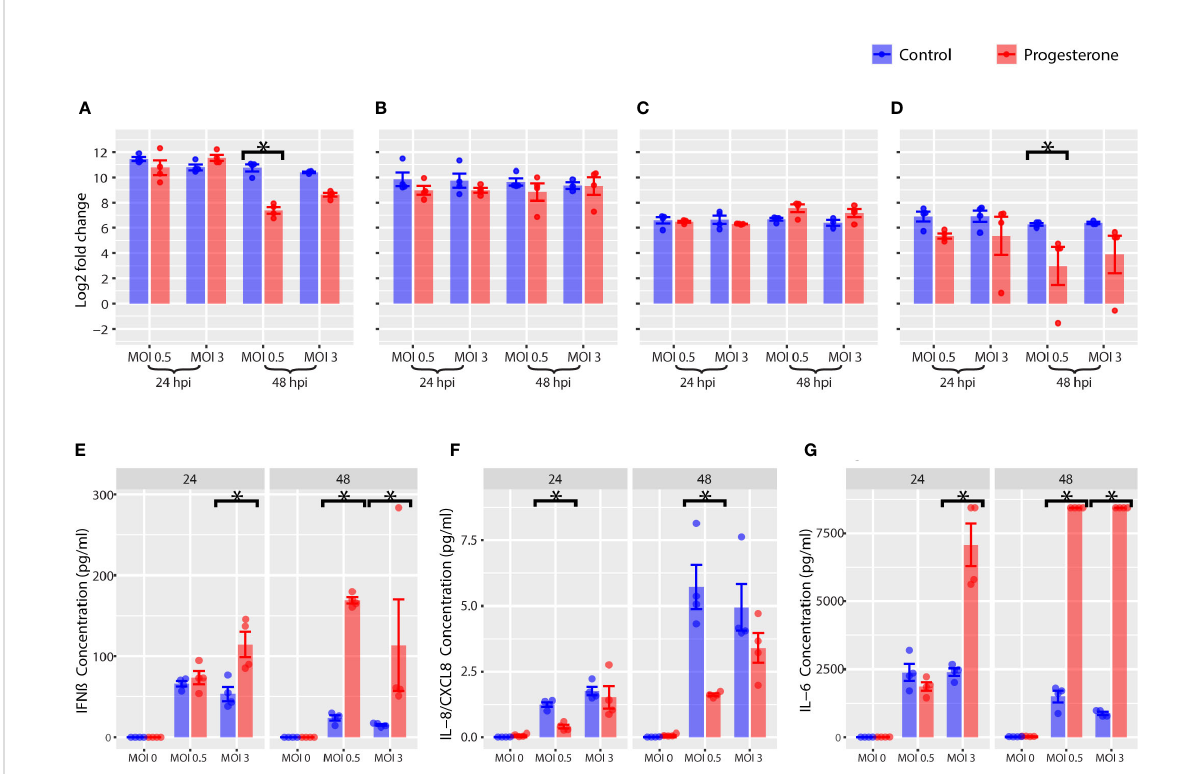
FIGURE 5 Innate immune response in ACH-3P, a placental cell line. Innate immune gene expression was measured by RT-qPCR. Log2 fold change values are reported for IFNB (A) , IFIT1 (B) , MXA (C) , and IL6 (D) . The cytokine levels in the supernatant of ACH-3P cells were measured with Luminex. Concentrations are reported for IFN- b (E) , IL-8 (F) , IL-6 (G) . *p-value was less than 0.05, as determined by the statistical analysis detailed in the Methods